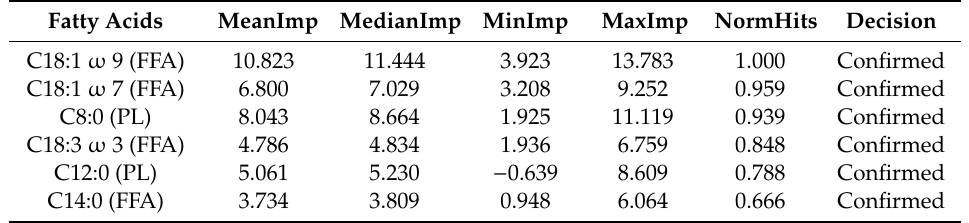
Table 3. Mean, median, minimum value, maximum value and normal value of importance of the 6 predictive fatty acids (FAs).